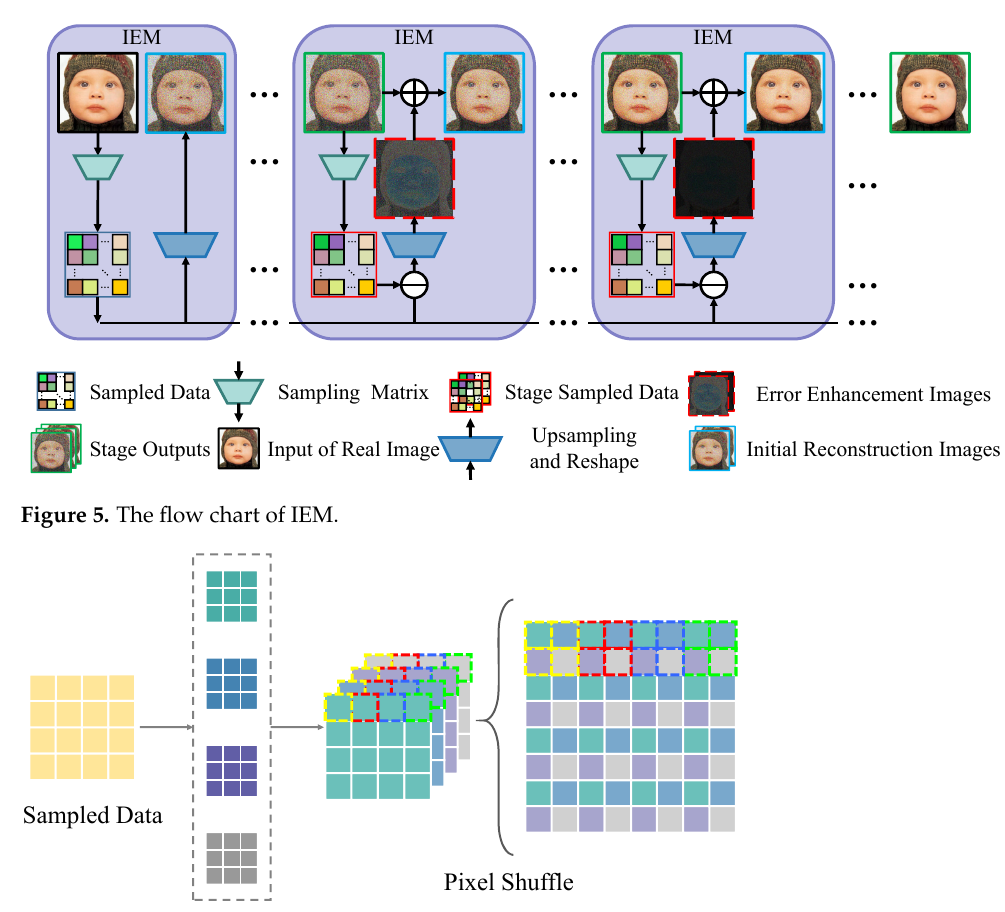
Figure 6. The understructure of the upsampling and reshaping module. The first stage is to stretch the dimension of SD into the same dimension as X to obtain the IRI through convolution, and the second stage is the hardware-friendly reshaping based on the pixel